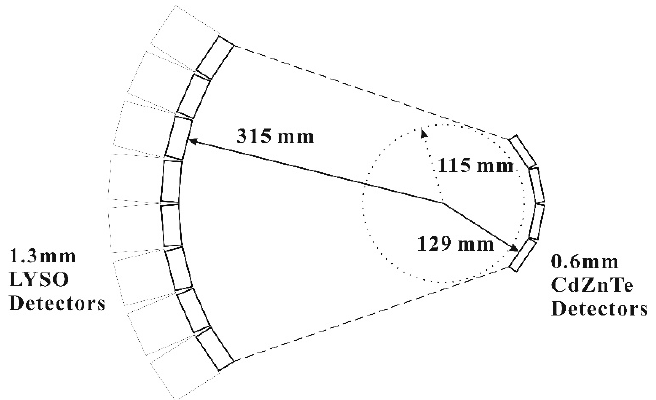
Figure 1. Experimental setup of the prototype positron emission tomography (PET) imaging system. The insert detectors were 0.6 mm pixelated CdZnTe detectors, and the PET scanner detectors were lutetium-yttrium oxyorthosilicate (LYSO) arrays with a 1.6 mm pitch.